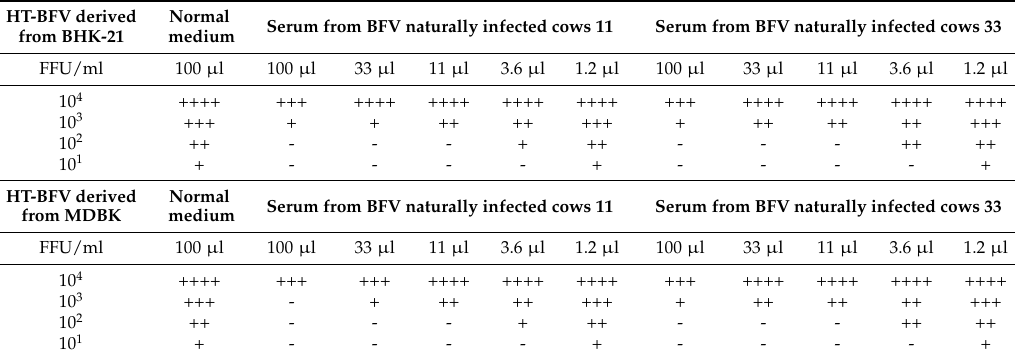
Table 2. Neutralization of high titer (HT)-BFV by serum from BFV-infected cows 11 and 33. HT-BFV derived Normal from BHK-21 medium